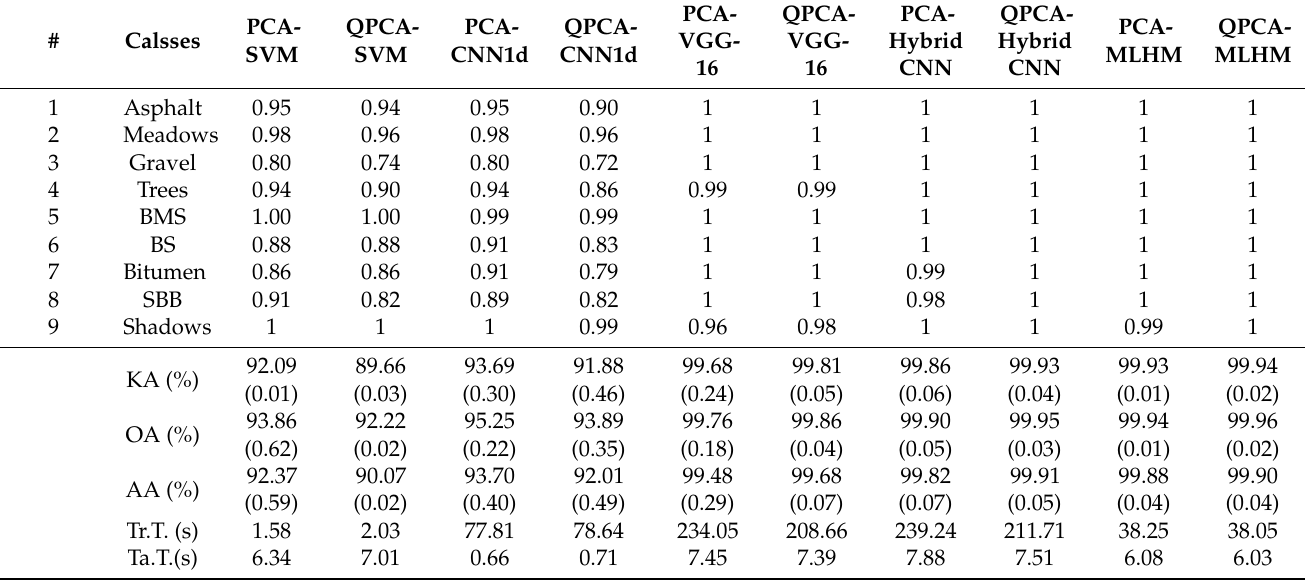
Table 7. The comparison of the various models with PCA and QPCA preprocessing for the Pavia- University